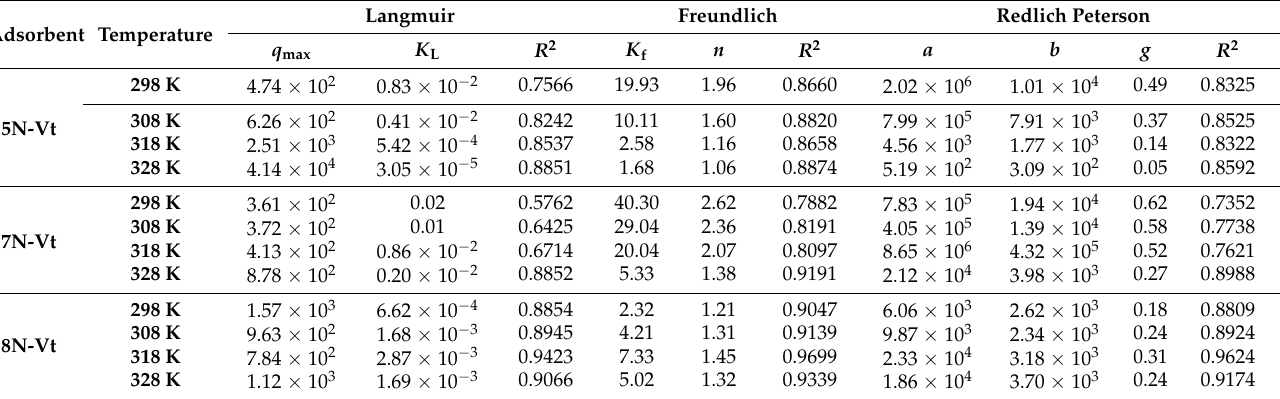
Table 4. Adsorption isotherm constants for adsorption of BPB for organo-Vts.